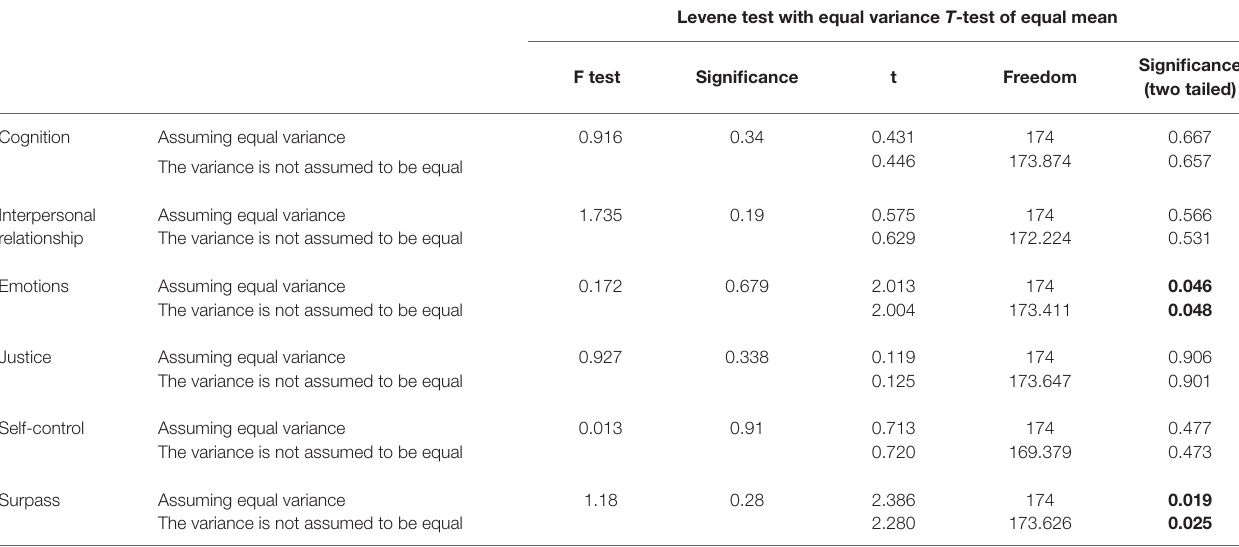
TABLE 5 | Comparison of pre-test and post-test differences between the experimental group and the control group.